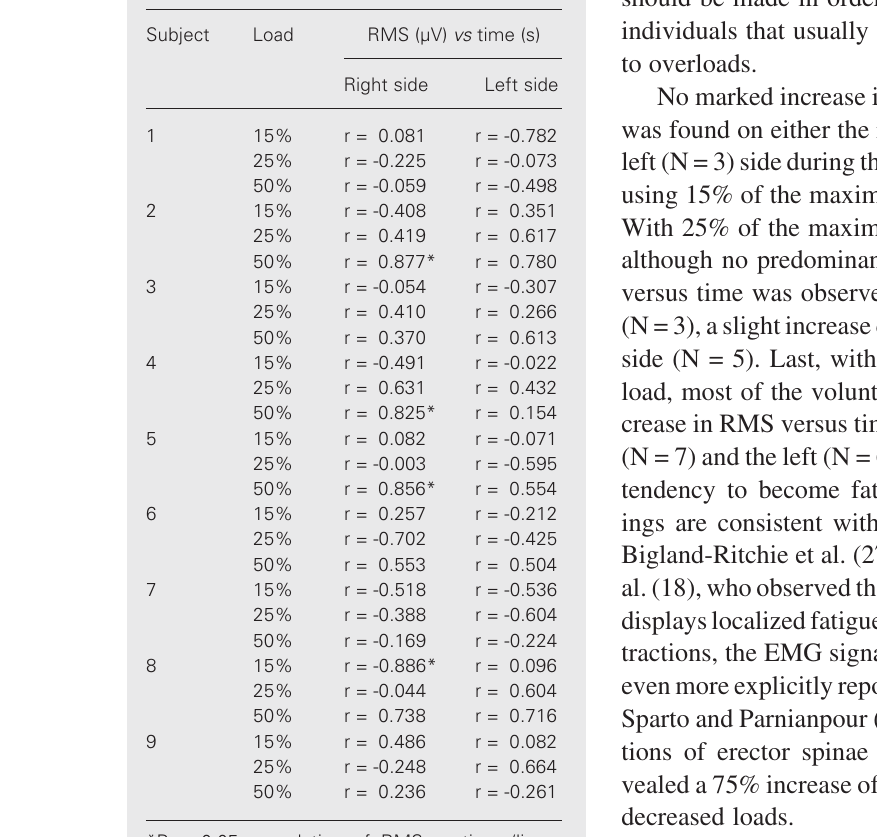
Table 2. Correlation between root mean square (RMS) and time during the 1-min test on both the right and left sides with the application of 15, 25 and 50% of maximum